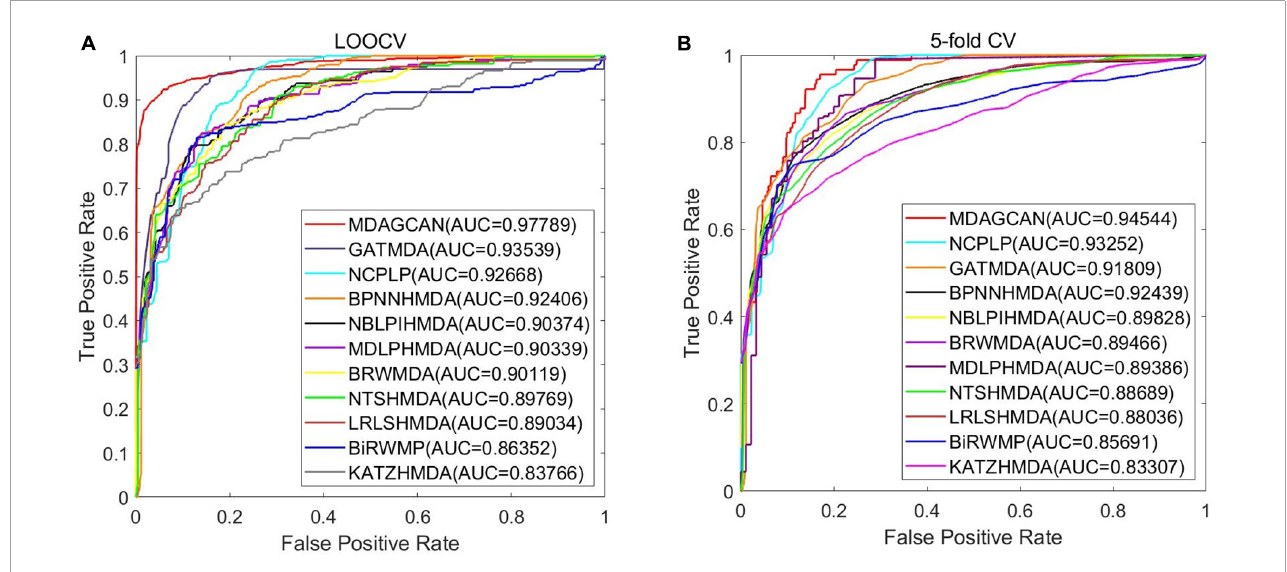
FIGURE2 Prediction performance comparison between MDAGCAN and 10 baseline methods on the HMDAD dataset in LOOCV (A) and 5-fold CV (B) .